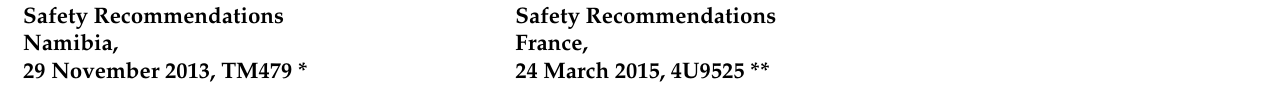
Table 4. Safety recommendations related to the accidents in Namibia [18] and France